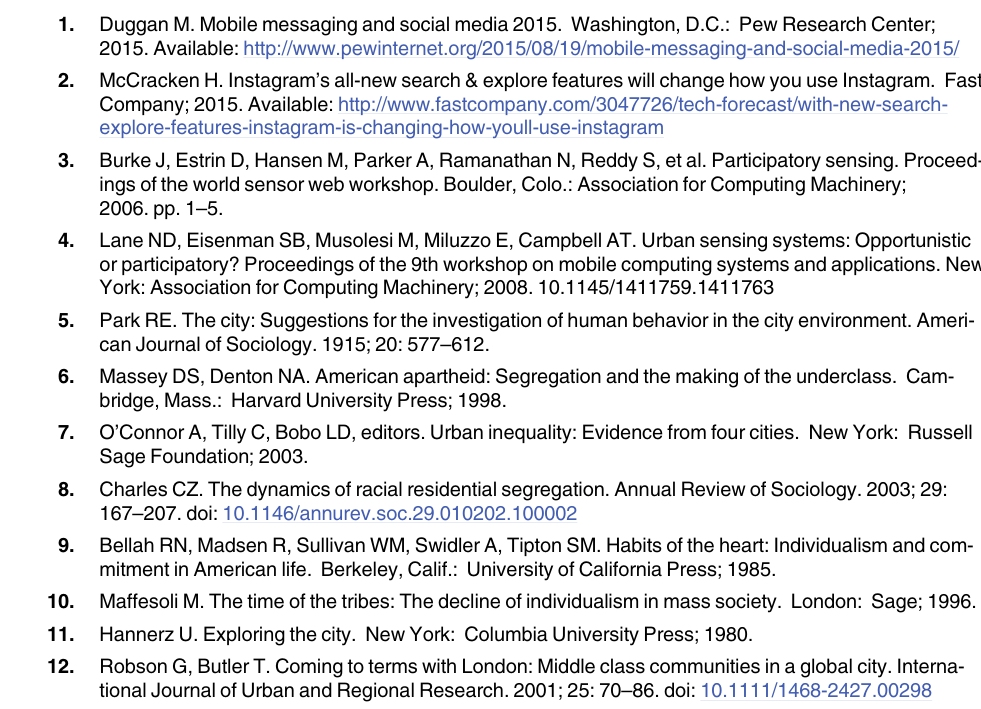
S1 Fig. Page Rank distributions of cluster